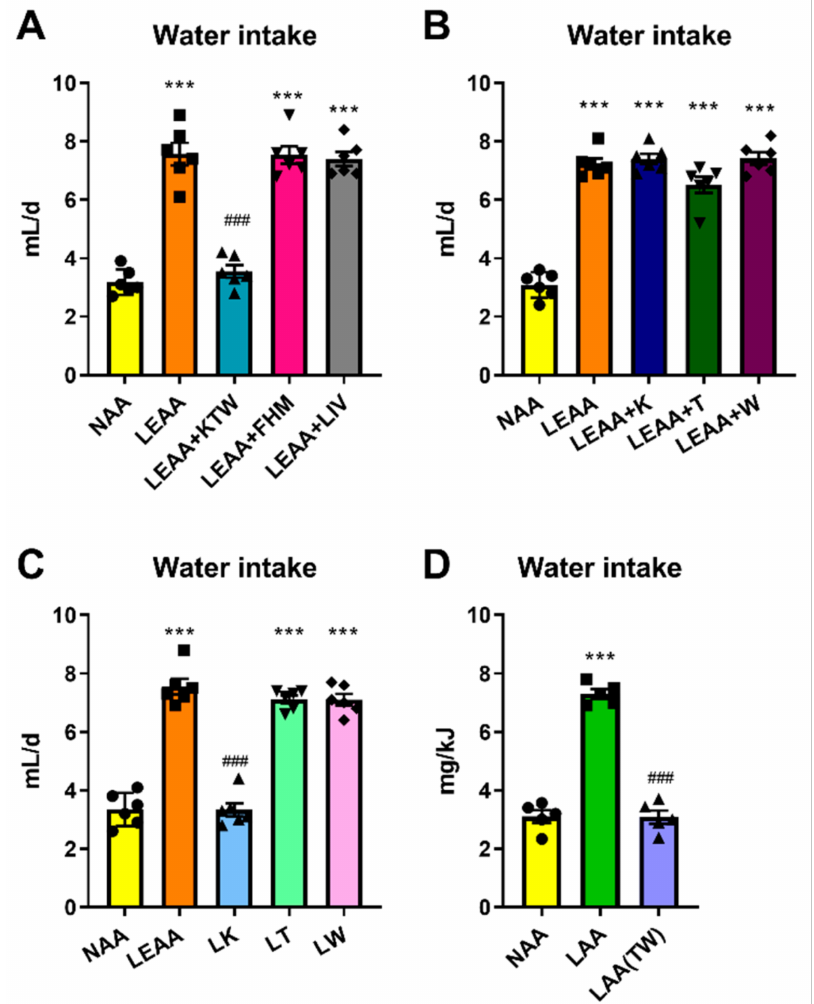
Figure 2. Restriction of Threonine and Tryptophan is sufficient and necessary for the effect of dietary protein dilution on hyperdipsia. ( A ): Water intake rate of mice fed a normal amino acid diet (NAA, 18% calories from AA), a low essential amino acid diet (LEAA) with EAA at values of a 4.5% total AA diet, and a LEAA diet supplemented with either lysine, threonine, and tryptophan (LEAA + KTW), phenylalanine, histidine, and methionine (LEAA + FHM), or leucine, isoleucine, and valine (LEAA + LIV). All diets were adjusted to 18% AA in total by non-essential AA (NEAA) top-up. Data are mean ± SEM ( n = 6 per group). Different than diet NAA: *** p < 0.001. Different than diet LEAA: ### p < 0.001. ( B ): Water intake of mice treated with NAA, LEAA, and LEAA supplemented with either lysine (LEAA + K), threonine (LEAA + T), and tryptophan (LEAA + W), all with NEAA equally adjusted to give 18%AA in total. Data are mean ± SEM; n = 6 mice per group. Different than diet NAA: *** p < 0.001. ( C ): Water intake of mice in response to treatment with the following diets NAA, LEAA, and diets with restricted amounts of either lysine (low lysine, LK), threonine (LT), and tryptophan (LW). All diets were equally adjusted with the other AA to give 18%AA in total. Data are mean ± SEM; n = 6 per group. Different than diet NAA: *** p < 0.001. Different than diet LEAA: ### p < 0.001. D: Water intake of mice in response to treatment with the following diets: NAA (normal amino acid, 18% energy from AA), LAA (low AA, 4.5% AA as used in Figure 1C), and LAA supplemented with threonine and tryptophan while keeping total AA at 4.5% (LAA(TW). Data are mean ± SEM ( n = 5 per group). Different than NAA: *** p < 0.001. Different than LAA: ### p < 0.001. Statistical analyses: One-way ANOVA ( A – D